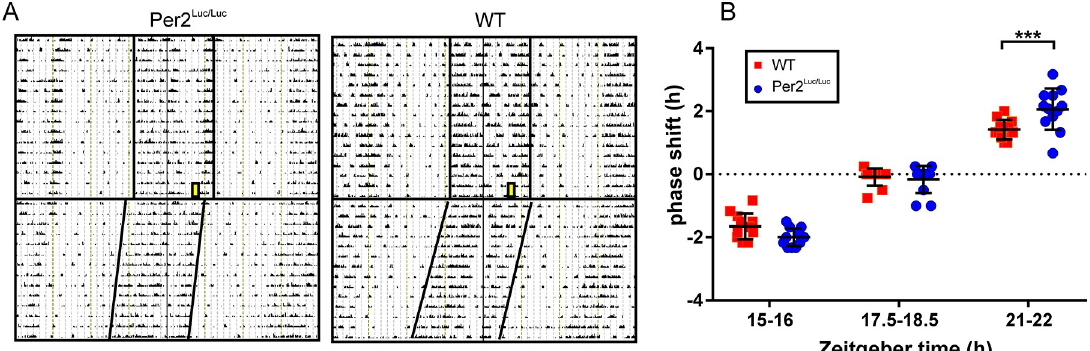
Fig 5. Phase dependent responses of OFA rhythms (phase shifts) to acute light exposure. WT and mPer2 Luc/Luc mice were entrained to LD12:12, exposed to a 1 h light pulse at different phases of the activity rhythms and released in DD. A. Representative actograms demonstrating the genotype-dependent difference in responses induced by light pulse administered at ZT21 (late night). B. Comparison of phase responses to light pulses between WT (n = 12) and mPer2 Luc (n = 12) mice in the early (ZT15), middle (ZT17.5) and late (ZT21) subjective night. Significant difference in phase responses between genotypes was found only at ZT21. ��� = p < .001. Error bars = SEM.